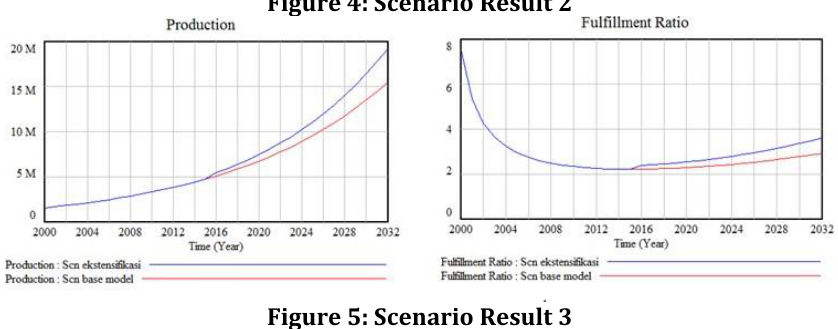
Figure 4: Scenario Result 2